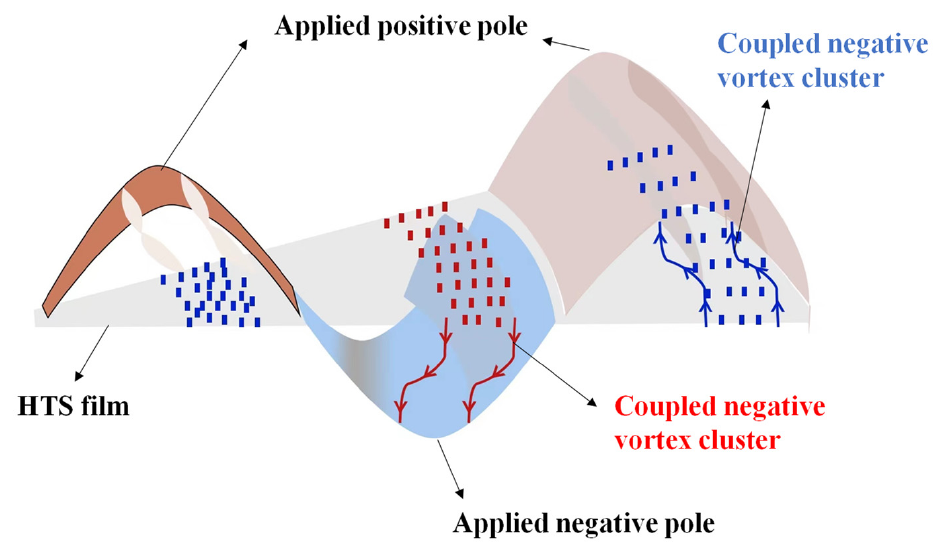
Figure 9. Coupling features including the ramping up of vortex density and misalignment between applied pole and coupled cluster. Adapted from [80].